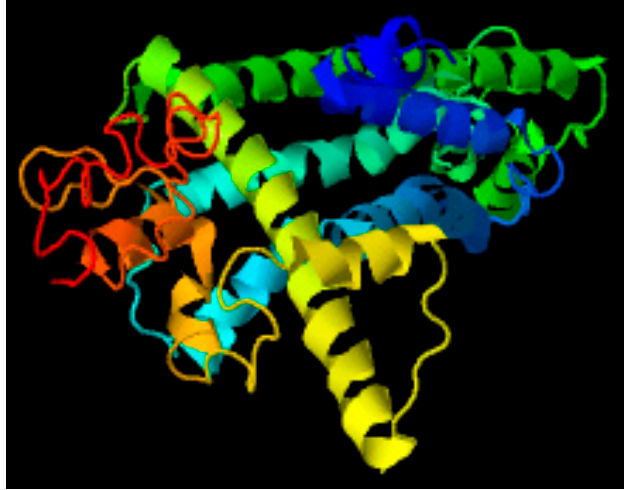
Figure 7. Best predicted model by LOMETS.